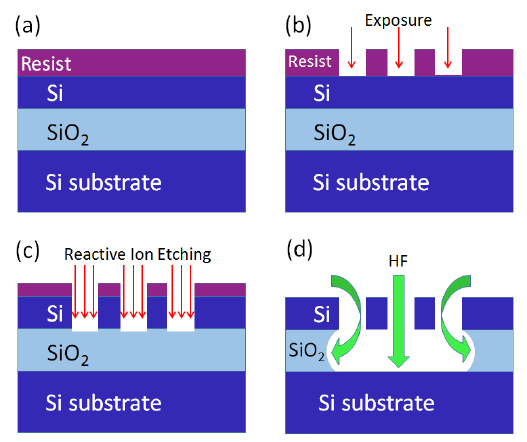
Fig. 2. The flow of fabricating silicon PhC slow-light waveguides us- ing CMOS processes. (a) Photoresist spin coating on top of the SOI wafer. (b) Electron beam lithography for high-resolution